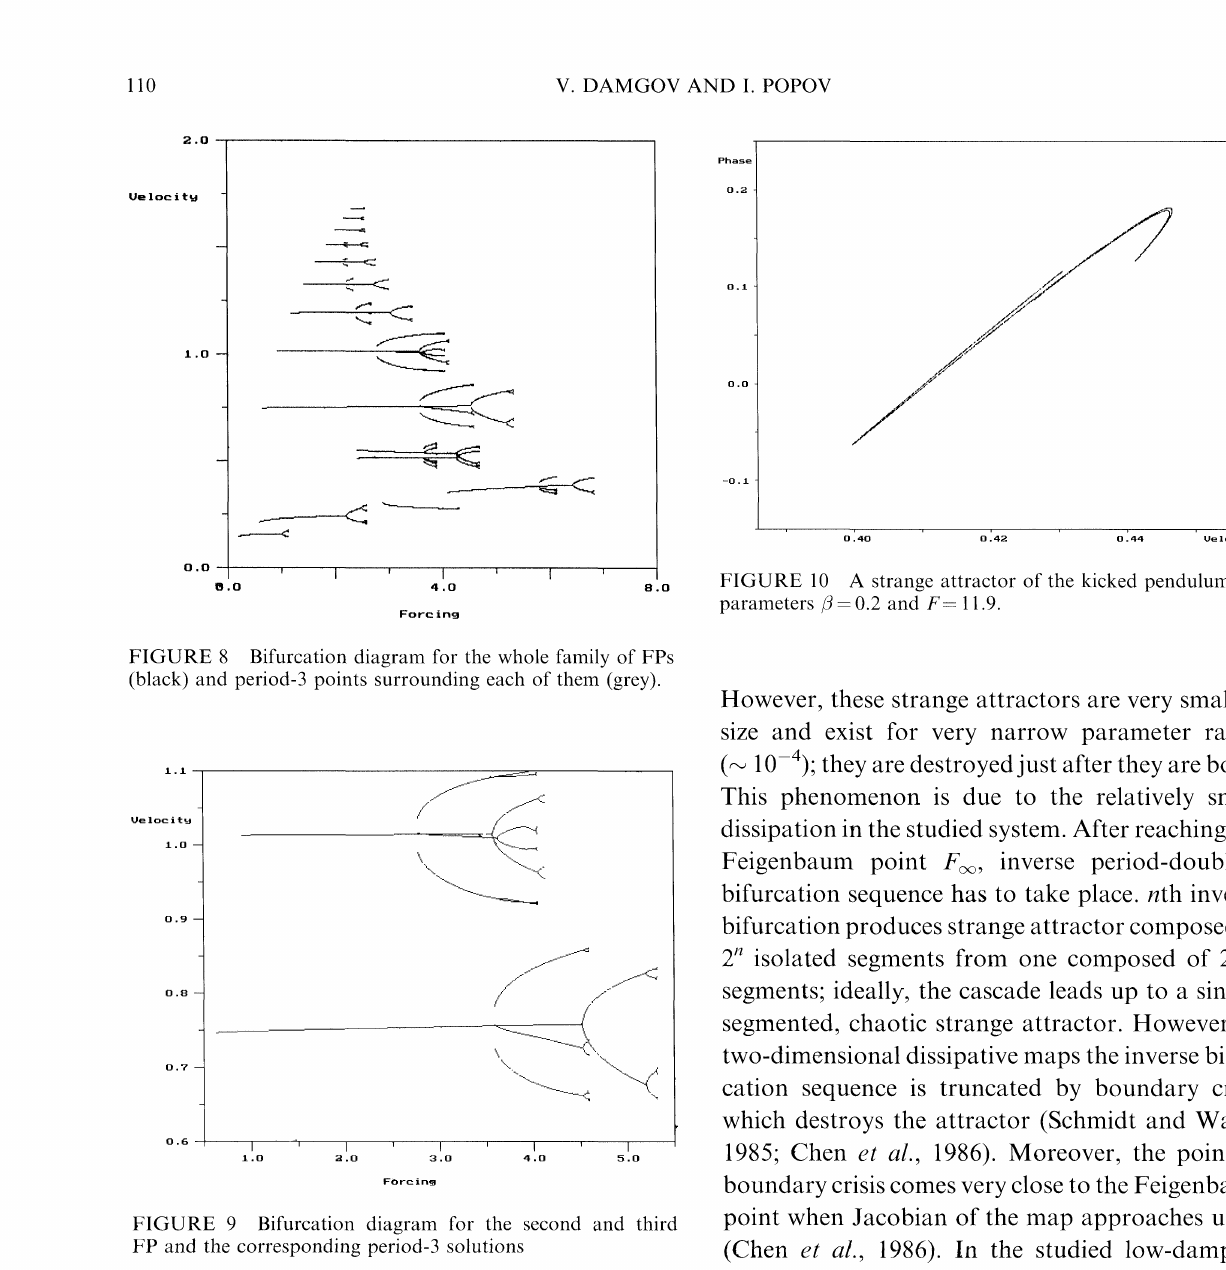
FIGURE 9 Bifurcation diagram for the second and third FP and the corresponding period-3